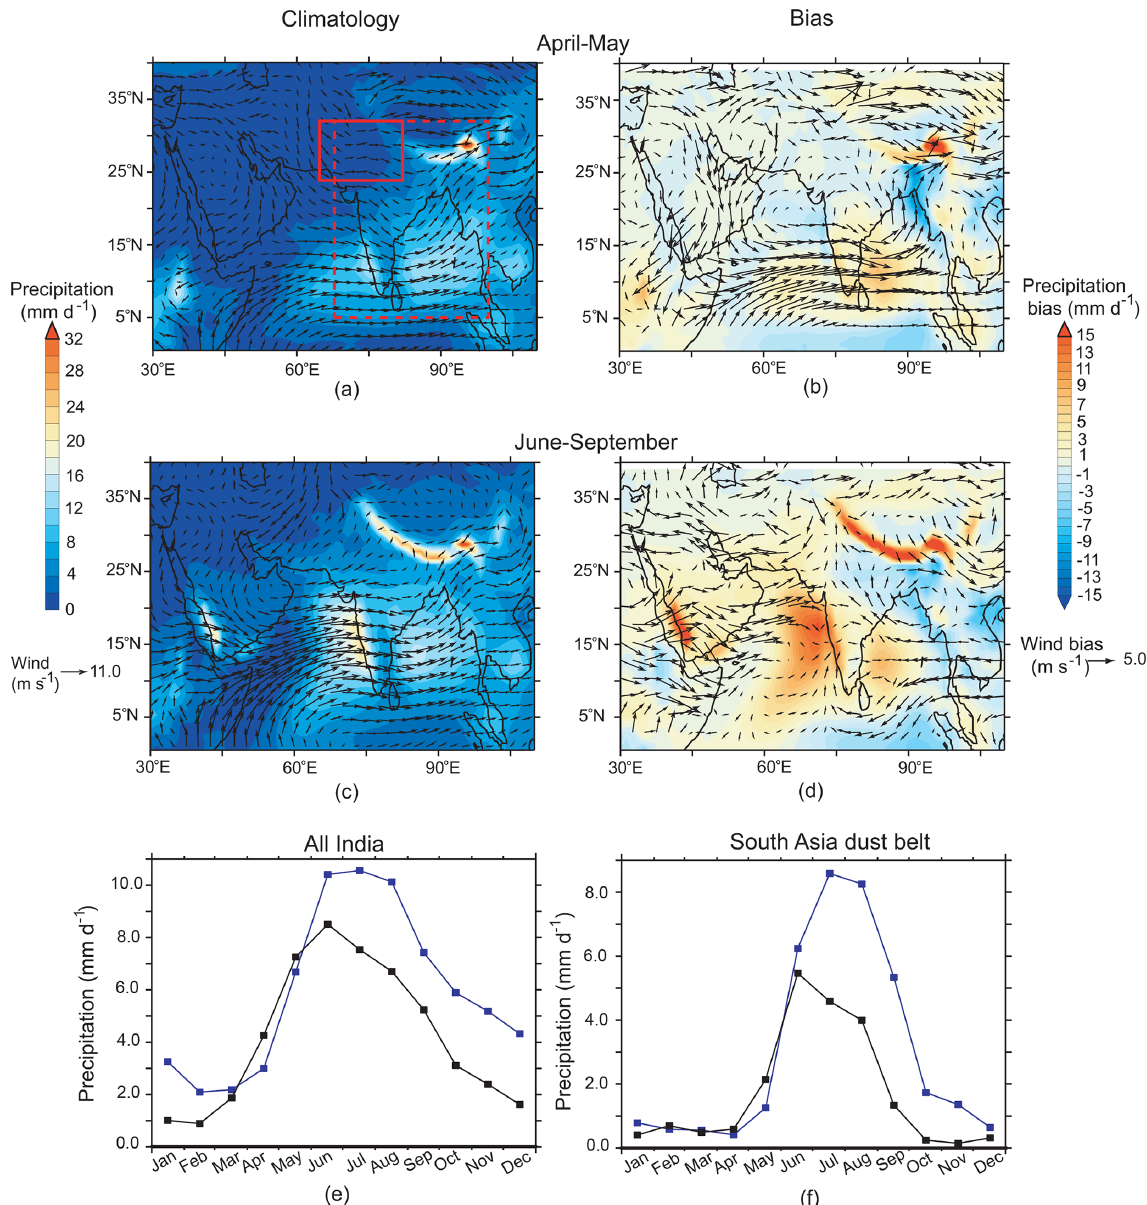
Figure 2. Comparison of the CESM Ctrl simulation with observations/reanalysis data. CESM-simulated climatology of precipitation and wind for (a) April–May and (c) June–September are shown. Differences between CESM-simulated precipitation (shading) and PERSIANN values and between CESM-simulated wind (arrows) and NCEP/NCAR Reanalysis values at the 850hPa pressure level are given for (b) April–May and (d) June–September. The time evolution of CESM (blue curve) and PERSIANN precipitation (black curve) over (e) all of India (5–32 ◦ N, 68–100 ◦ E) and (f) the South Asian dust belt (24–32 ◦ N, 65–82 ◦ E); these domains are indicated by the dashed and solid red boxes in panel (a) ,